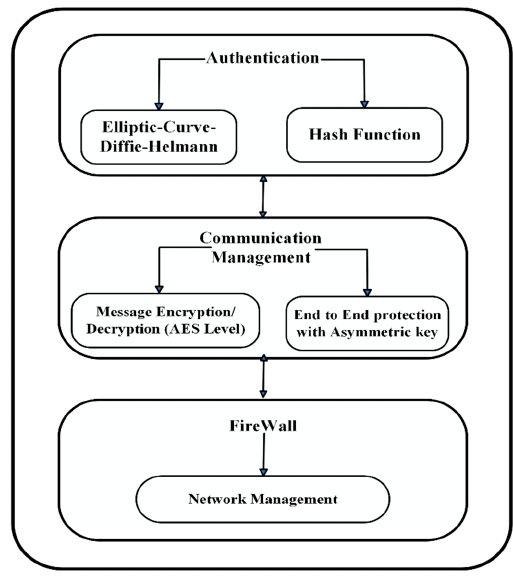
Figure 4. Three-layered authentication approach.